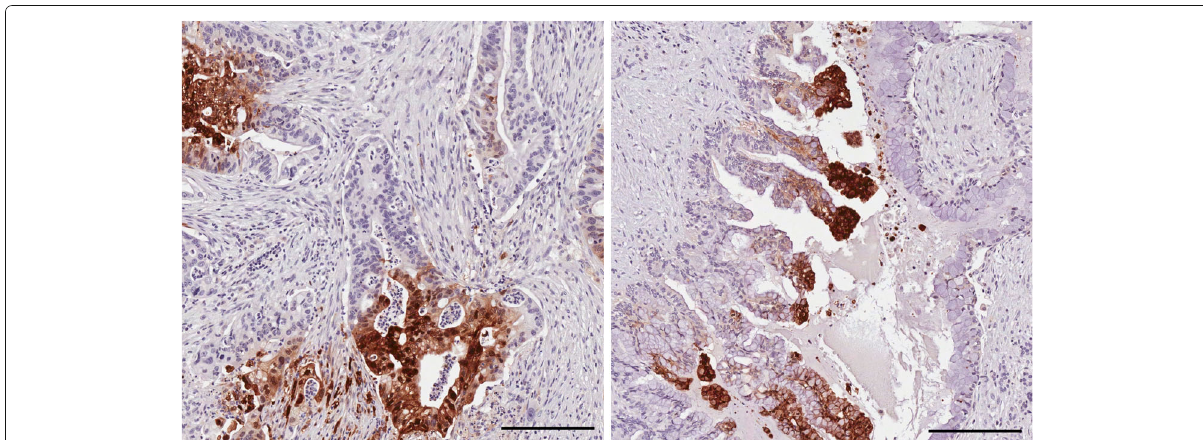
Fig. 7 Resected histology slices from two patients (16 and 17 in Online Resource 1 (Additional file 1)), illustrating the hypothesized dependence of the distribution volume on mucin expression. The tumour on the left exhibits little mucin while that on the right exhibits abundant apical mucin. The average distribution volumes for these tumours are 0.92 and 0.76, respectively, representing above- and below average levels. The black scale bars in the lower-right hand corners of these plots indicates a length of 200 μ m; in comparison, a PET voxel is ∼ 4 mm across. Brown regions indicate staining for